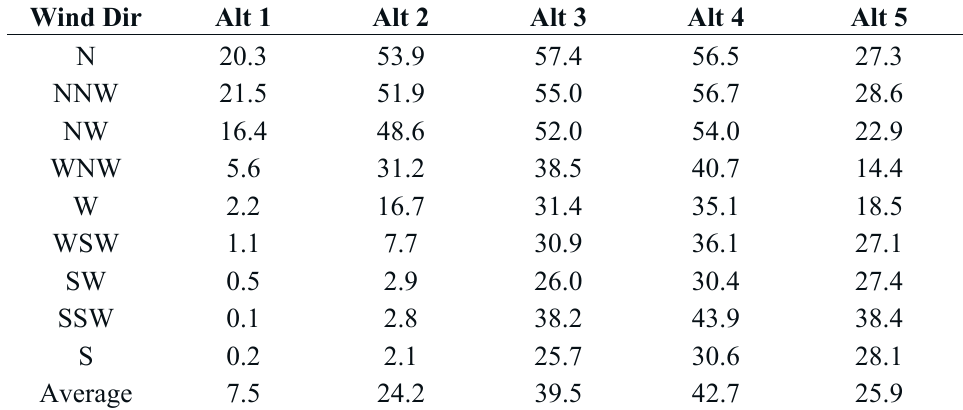
Table 3. Average wave height reduction factors along channel centerline (Sta 30 to 50) at WL = 0